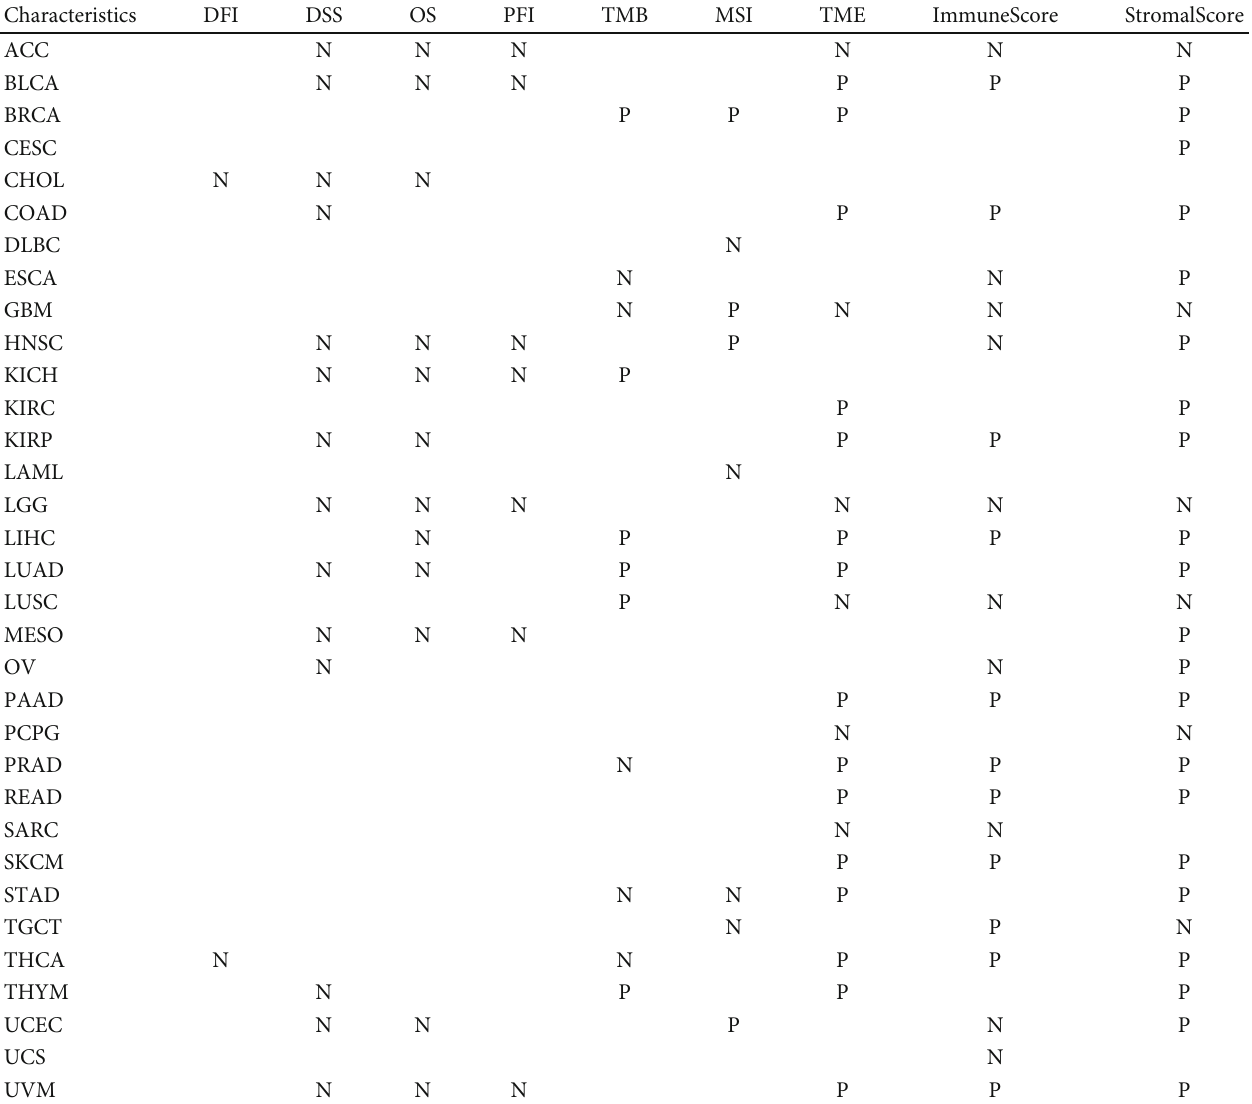
Table 1: Information of B4GALNT1 in human